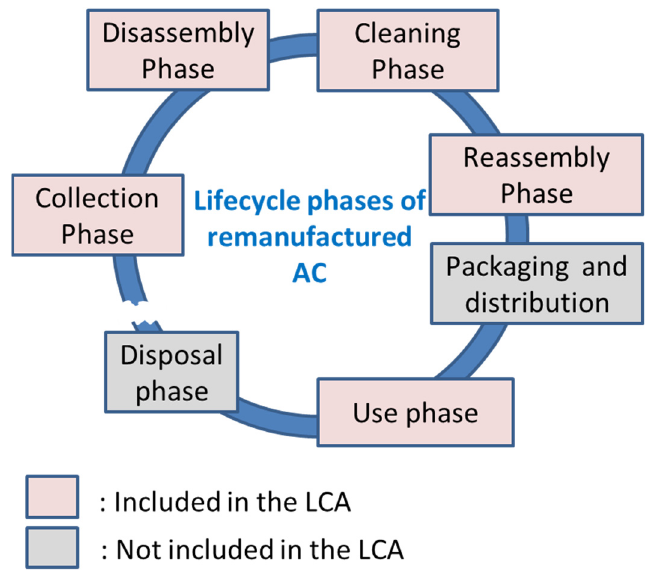
Figure 1. The life cycle phases of the remanufactured